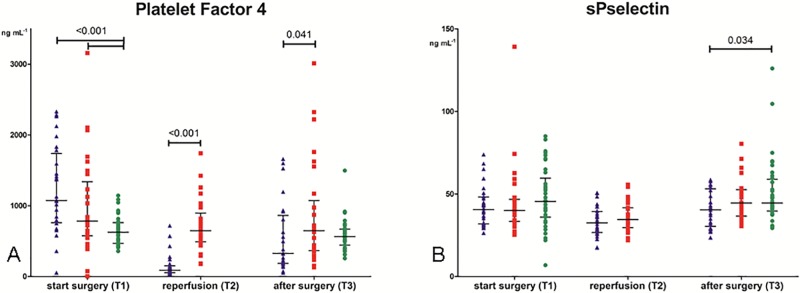
Markers of platelet activation.Fig 2A: Levels of platelet factor 4. Preemptive group (blue triangle), non-preemptive group (red square) and donors (green dot) before incision (T1), 5 minutes after reperfusion (T2) and 2 hours after surgery (T3). Data are given as medians with IQR. Fig 2B: Levels of soluble P-selectin. Preemptive group (blue triangle), non-preemptive group (red square) and donors (green dot) before incision (T1), 5 minutes after reperfusion (T2) and 2 hours after surgery (T3). Data are given as medians with IQR.